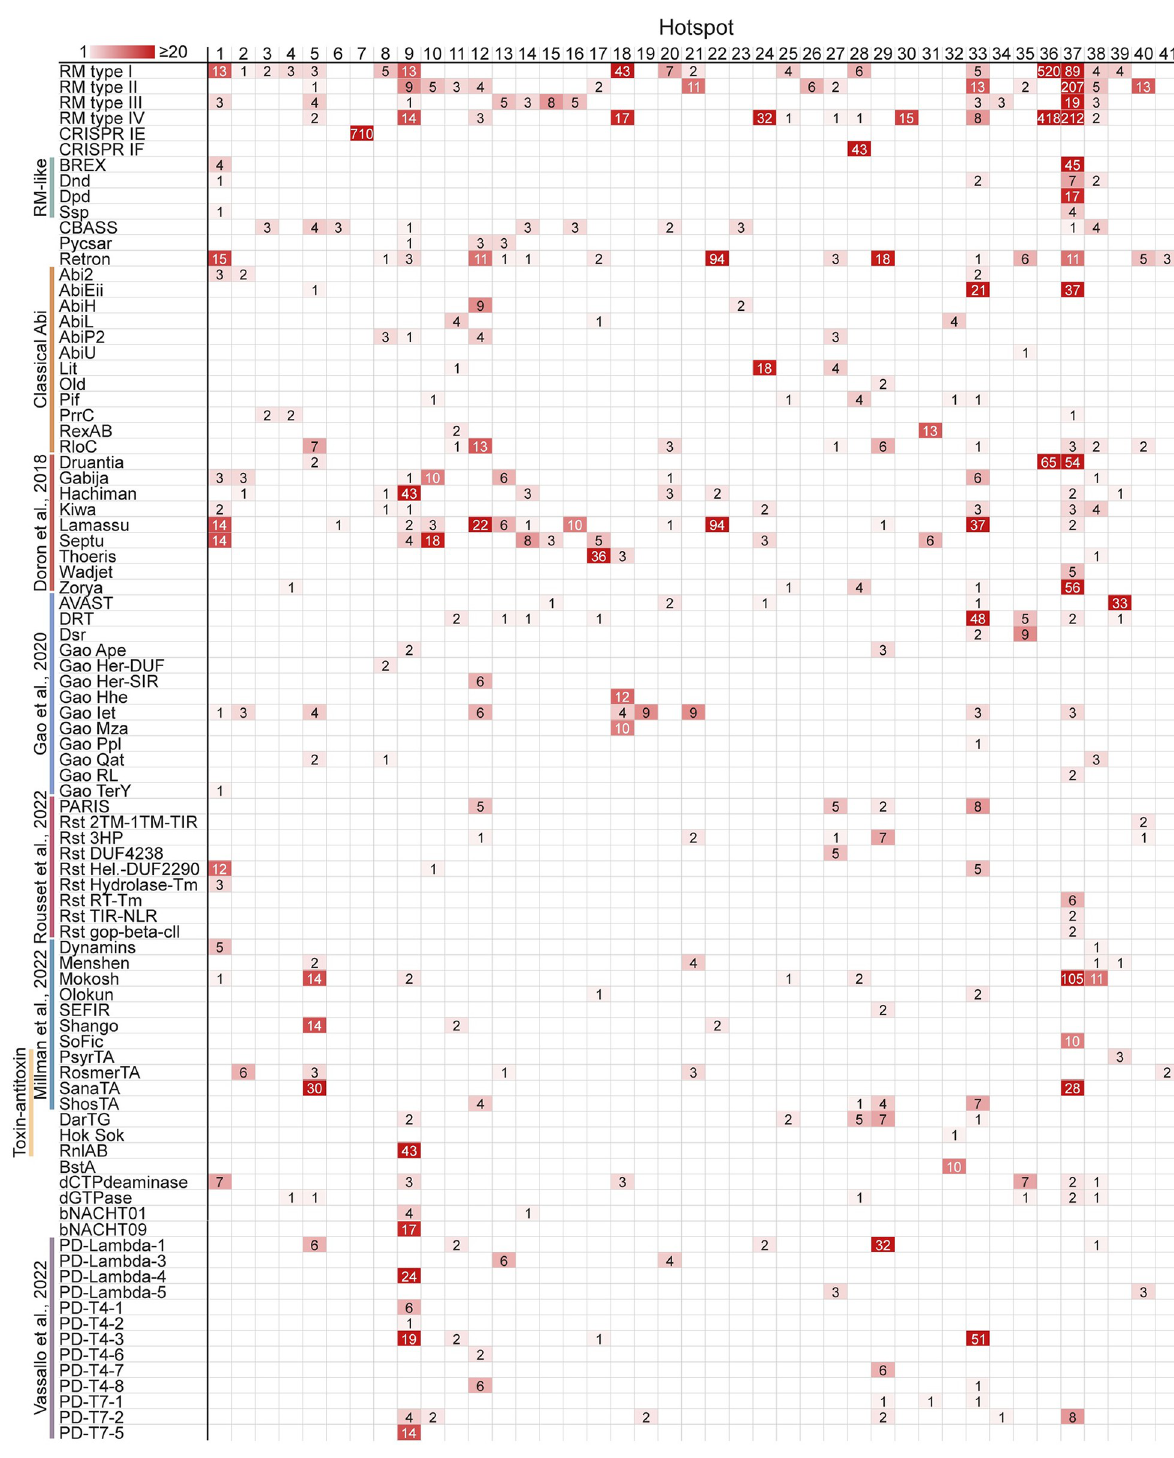
Fig 4. Defense system occupancy at 41 hotspots in the E . coli pan-genome. Numbers indicate the occurrences of each defense system within each hotspot, with red shading corresponding to the frequency.